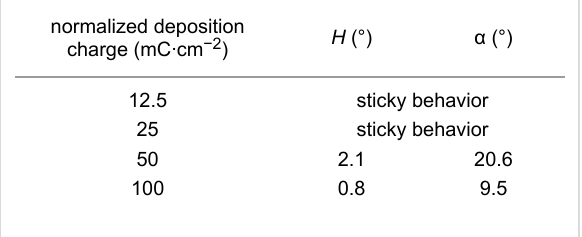
Table 3: Dynamic water contact angles (hysteresis H and sliding angle α ) for PIndole-6-F 6 as a function of the normalized deposition